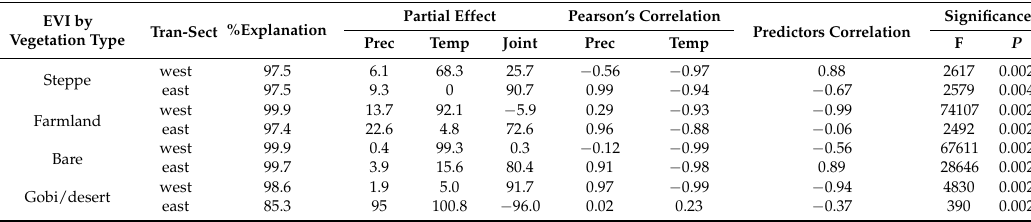
Table 7. Outcomes of RDA models over two transects and four plant communities. Partial Effect Pearson’s Correlation EVI by Predictors Correlation Vegetation Type Tran-Sect %Explanation